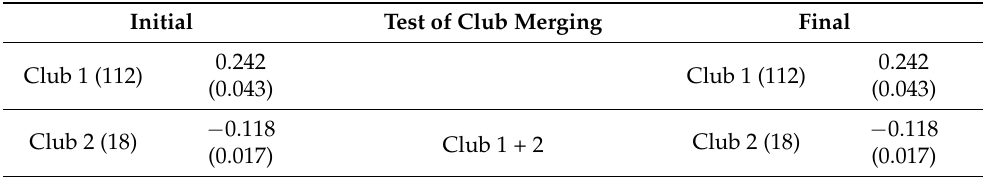
Table 1. Green growth indicators, change in the natural log convergence club classification (GGDP). Initial Test of Club Merging